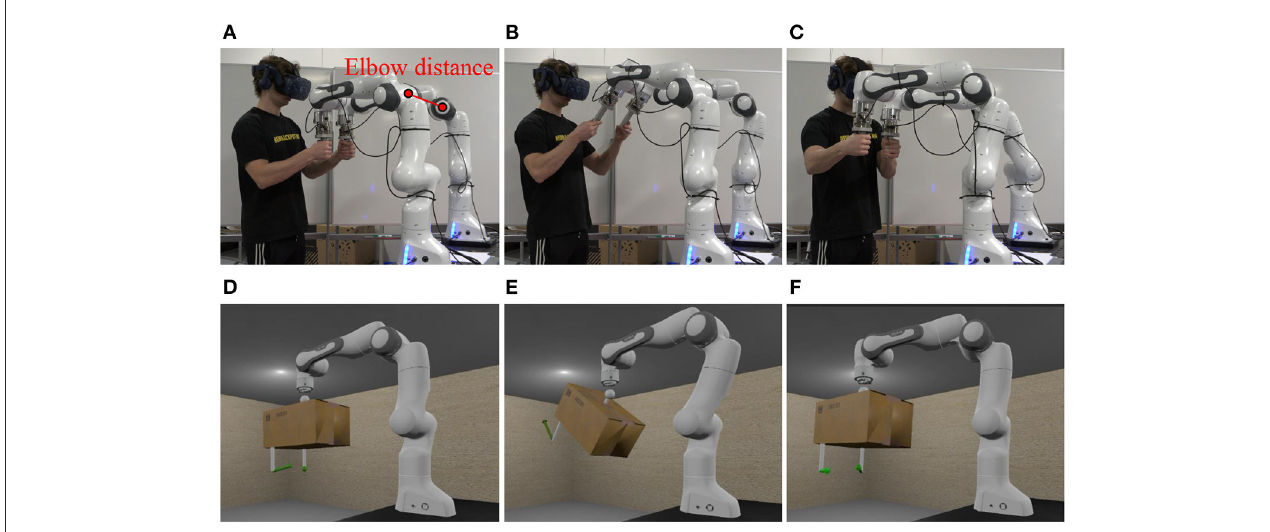
FIGURE5 Snapshots of an experiment of scenario 1 at 5s (A) , 18s (B) and 28s (C) , and the corresponding snapshots of the VR scene in the visual rendering module at 5s (D) , 18s (E) , and 28s (F) .